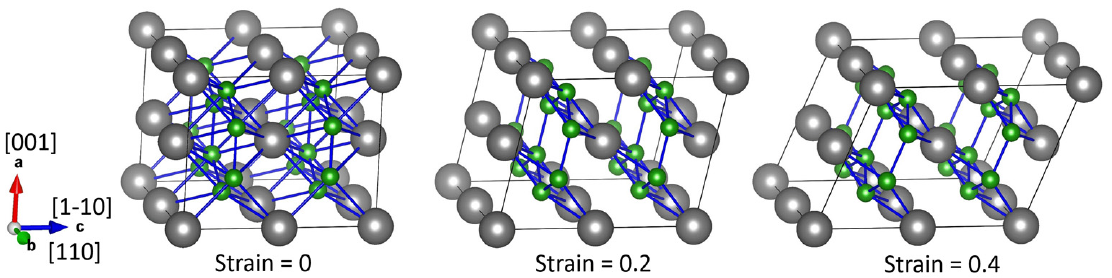
Figure 1. Schematic of shear deformation in HfB 2 along the (001) [1 − 10] shear direction at strain values 0, 0.2, and 0.4, respectively. The gray and green balls represent the Hf and B atoms, respectively.